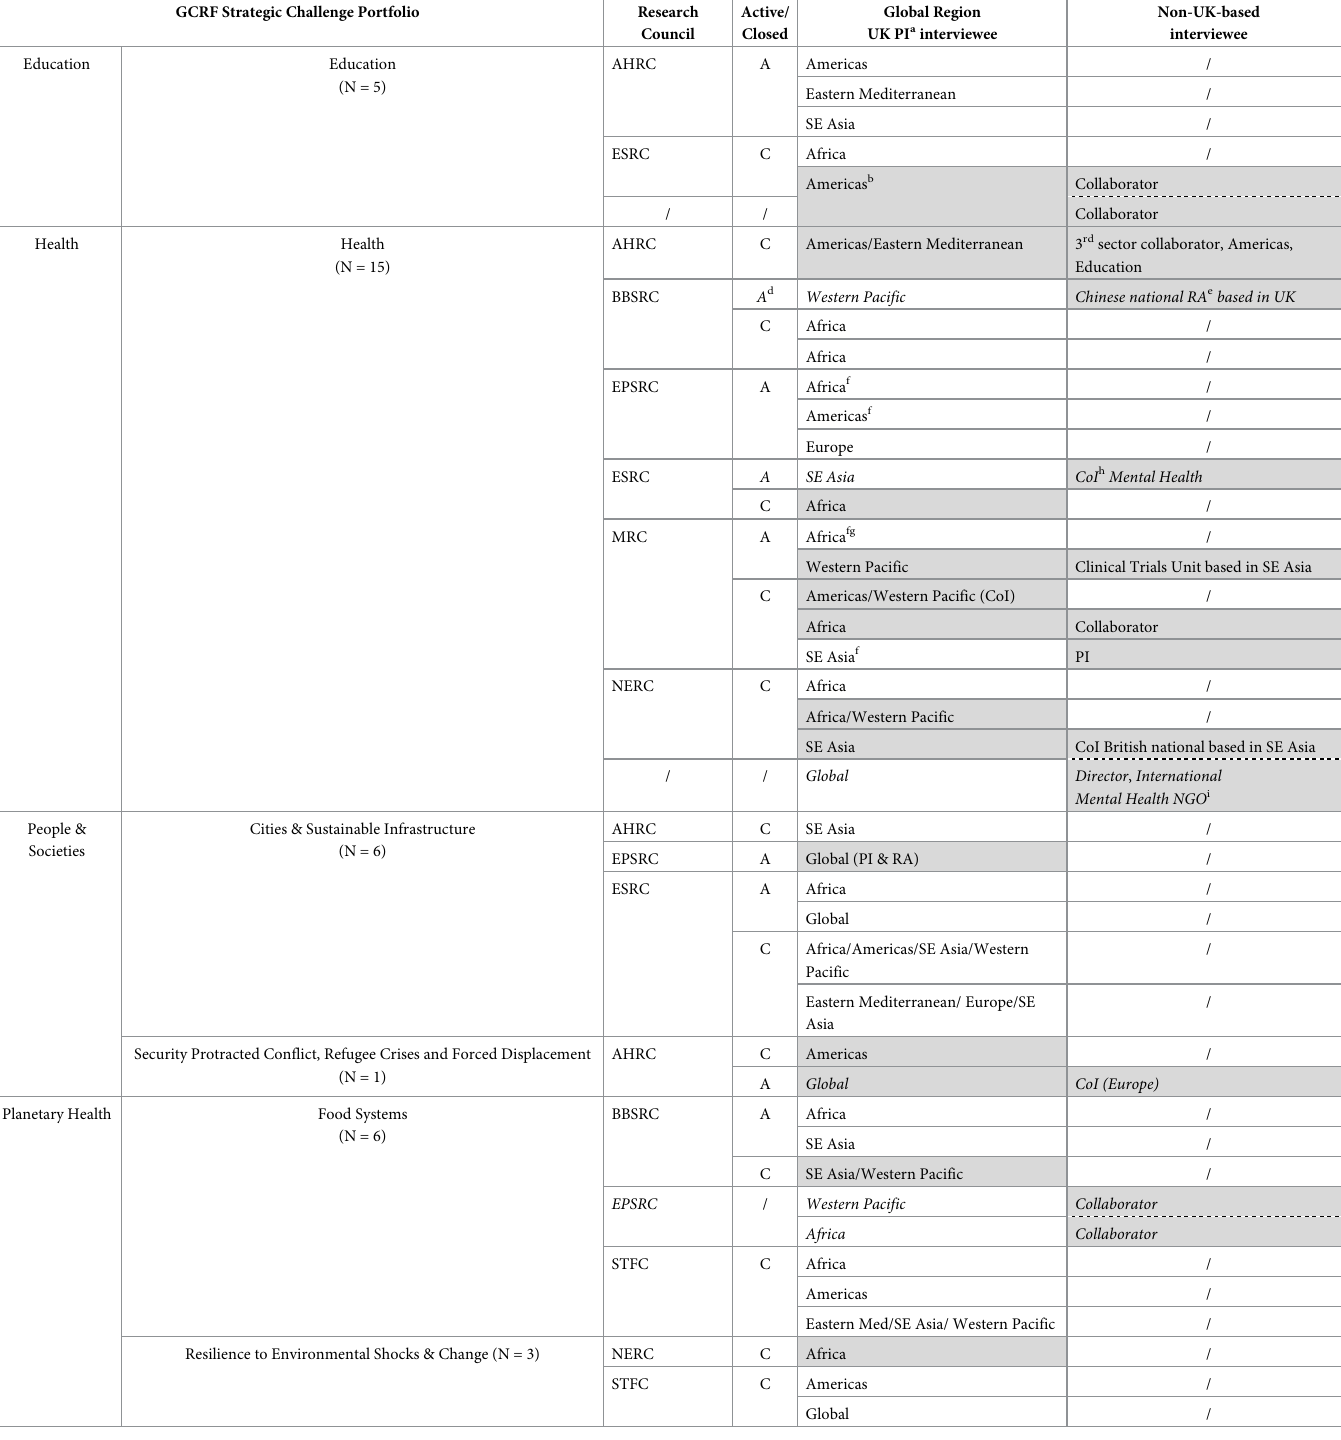
Table 1. Scoped projects by GCRF portfolio, research council, status, region and